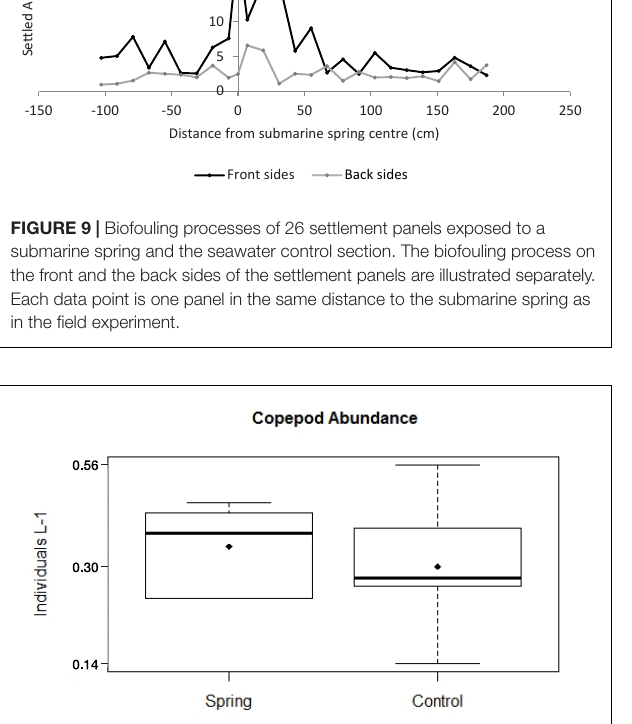
FIGURE 10 | Copepod abundances sampled within a diameter of six meters around a submarine spring and a seawater control